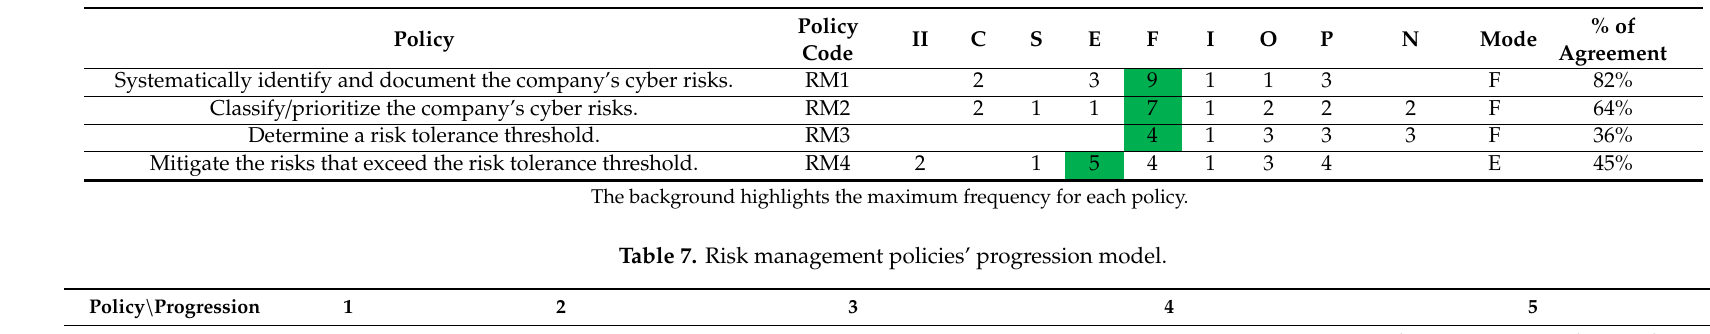
Table 6. Risk management policies’ progression type.